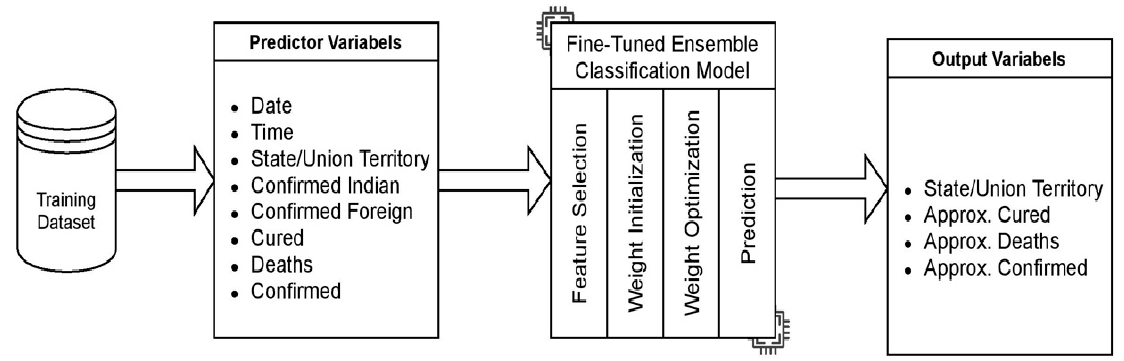
Figure 3. Features selected for the Predictor and Outcome variables.